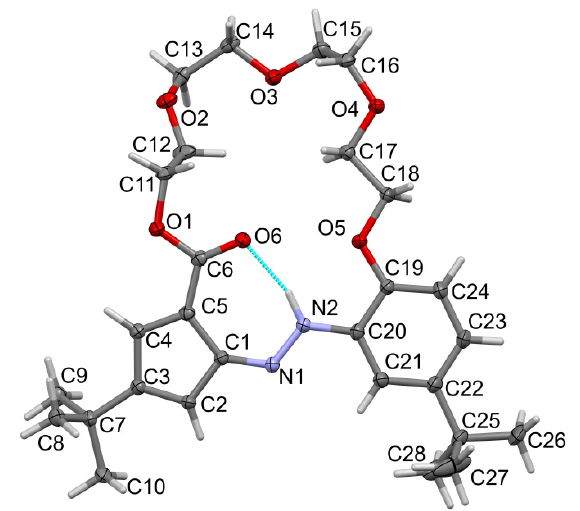
Figure 6. Molecular view of t -Bu-20-ester showing atom labelling scheme. Intramolecular hydrogen bonding is drawn as the dashed cyan line. Displacement ellipsoids are drawn at a 50% probability level. Selected bond lengths (Å) and angles ( ◦ ): N1-N2 1.317(3), N1-C1 1.322(4), N2-C20 1.400(4),